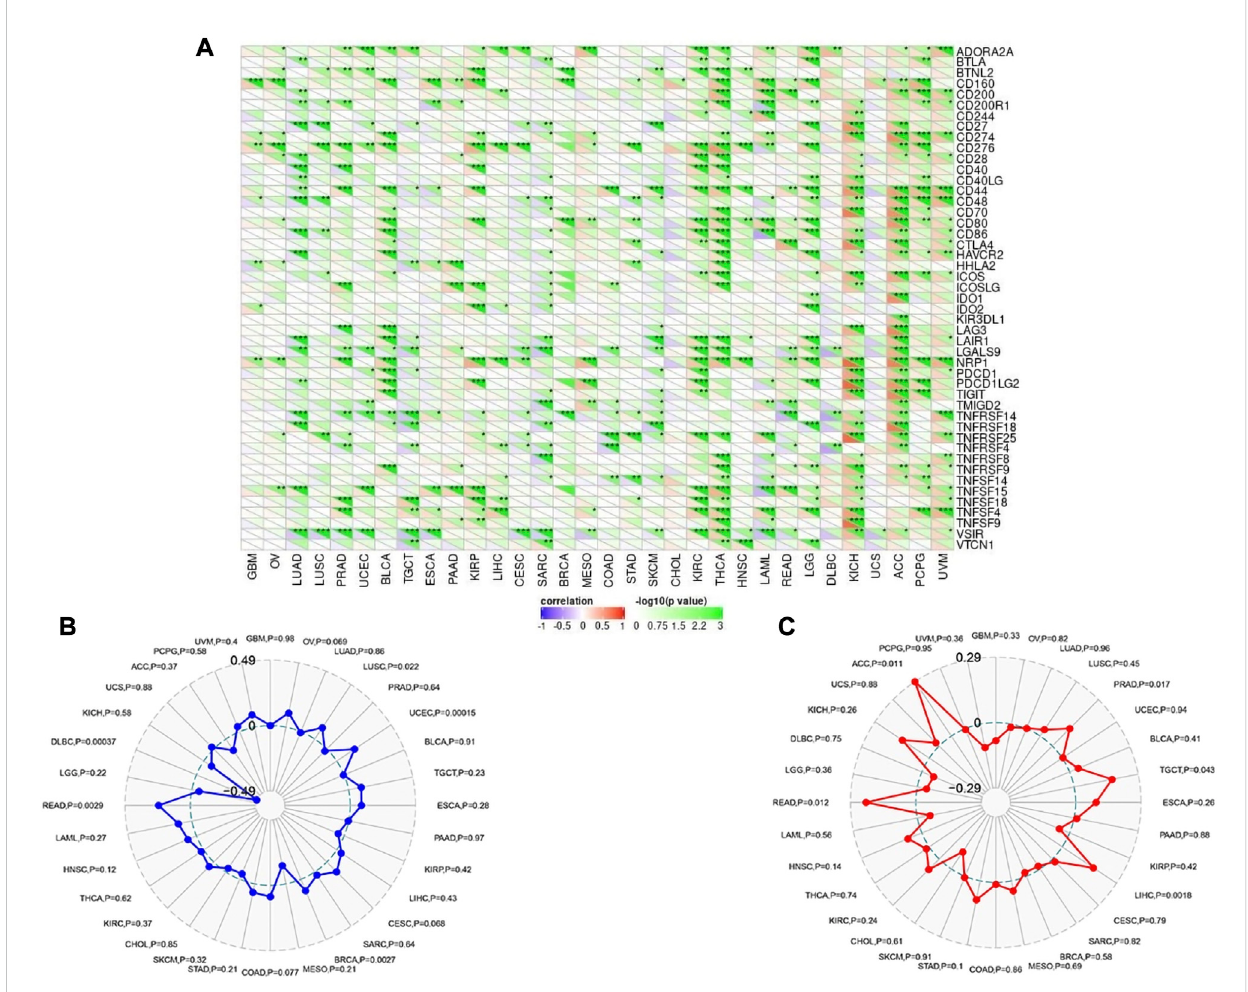
FIGURE 8 Correlations of CHD1L expression with immune checkpoints, MSI, and TMB. (A) Heatmap correlating the immune checkpoints and CHD1L across a list of human tumors. (B) and (C) are radar charts showing the overlaps of CHD1L with MSI and TMB